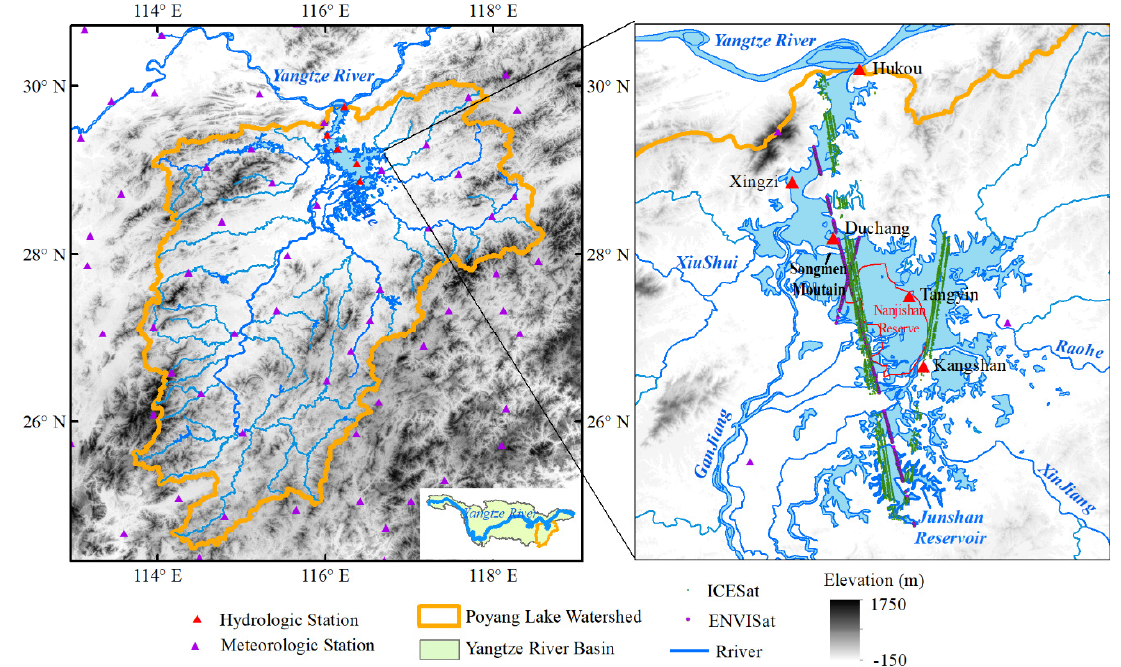
Figure 1. Spatial distribution of Poyang Lake and the feeding rivers in the watershed, and the paths of altimeter data on the